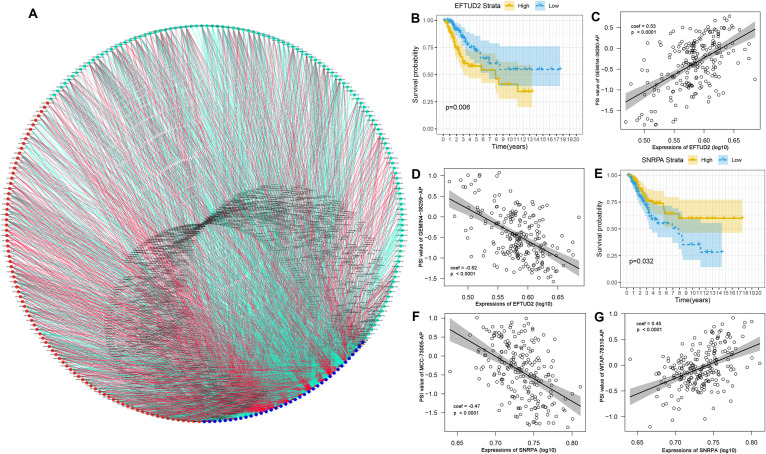
Correlation network of survival-associated SFs-AS in CC. (A) Correlation network between expression values of survival-related SFs and PSI values of survival-related AS, generated by Cytoscape. Blue dots indicate survival-related SFs. Cyan/Red dots indicate favorable prognostic/poor prognostic AS events, respectively. Red/cyan lines indicate positive/negative correlations between SFs and AS events. (B) Splicing factor EFTUD2 was related to prognosis in CC. The yellow line indicates a high expression group; the Blue line indicates a low expression group. (C) High expression of EFTUD2 was positively correlated to PSI values of GEMIN4-38260-AP. (D) High expression EFTUD2 was negatively correlated to PSI values of GEMIN4-38259-AP. (E) Splicing factor SNRPA was related to prognosis in CC. The yellow line indicates a high expression group; the Blue line indicates a low expression group. (F) High expression of SNRPA was negatively correlated to PSI values of MCC-73005-AP. (G) High expression of SNRPA was positively with PSI values of WTAP-78310-AP.